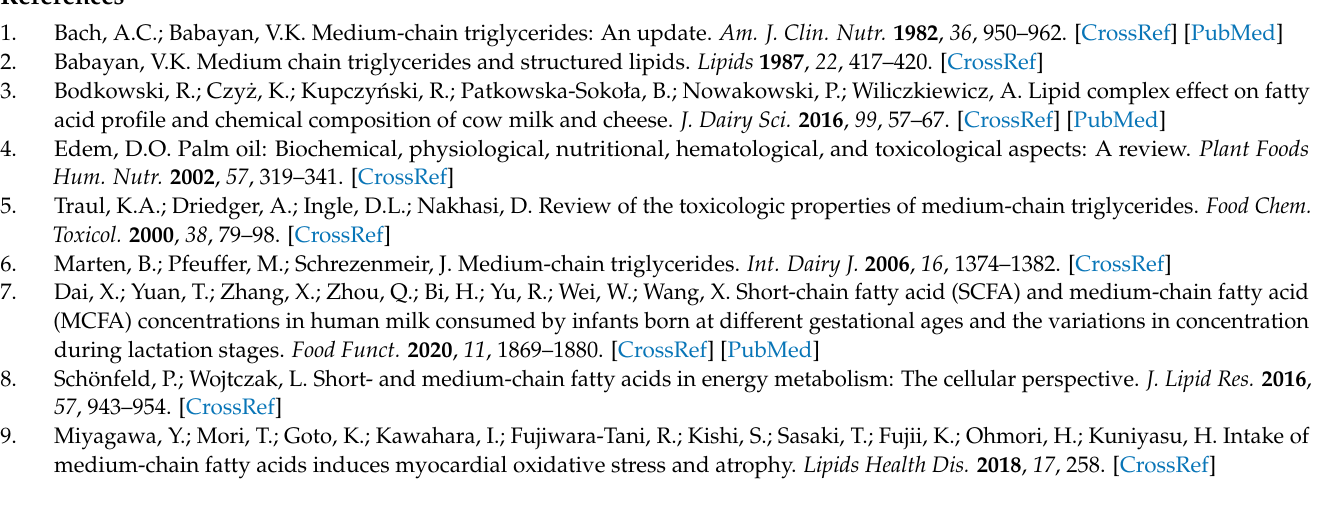
Table S2: Total ketones and AcAc levels ( µ mol/L); Figure S2: CorrPlots (page 1 contains all data; page 2 contains only significant